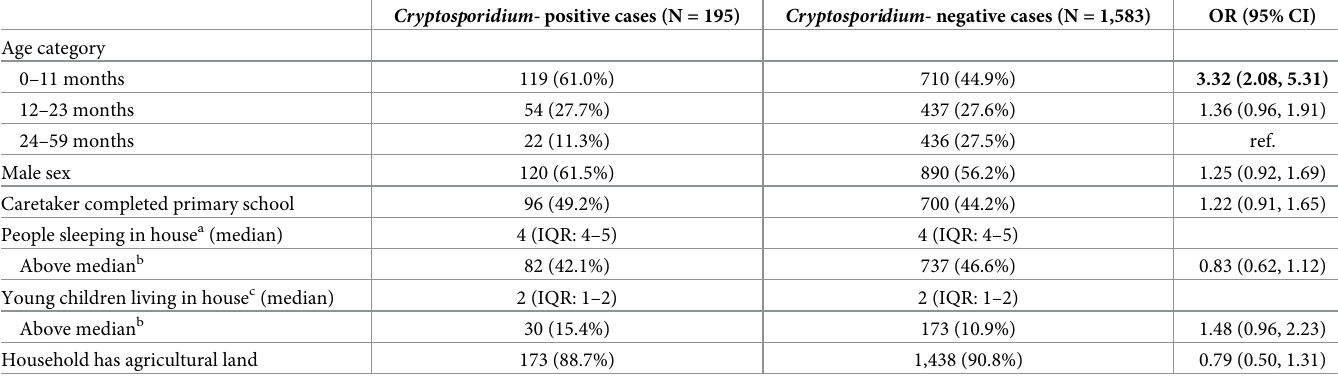
Table 1. Demographic and household characteristics of GEMS-Kenya cases (N = 1,778) by Cryptosporidium status, western Kenya, 2008–2012. Cryptosporidium- positive cases (N =